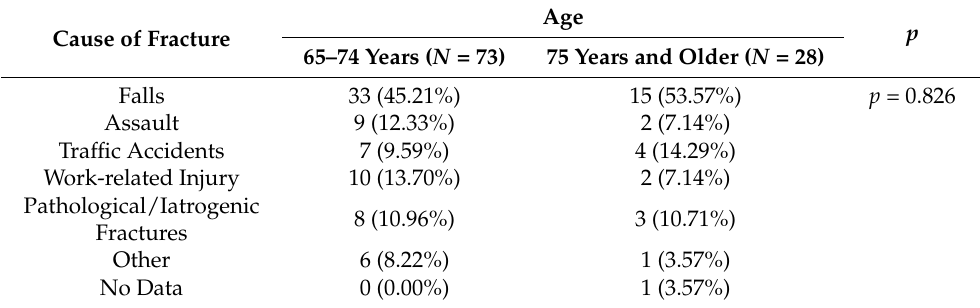
Table 10. Age and cause of